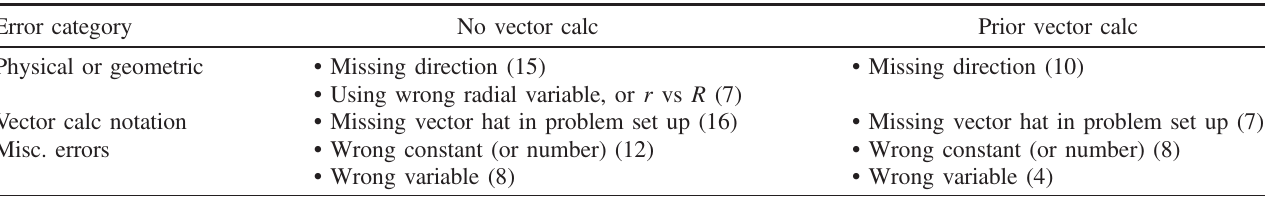
TABLE V. Error counts from qualitative analysis of FR1a. Number in brackets is the number of students for whom we found a mistake, out of 66 total students in each category (No vector calc and prior vector